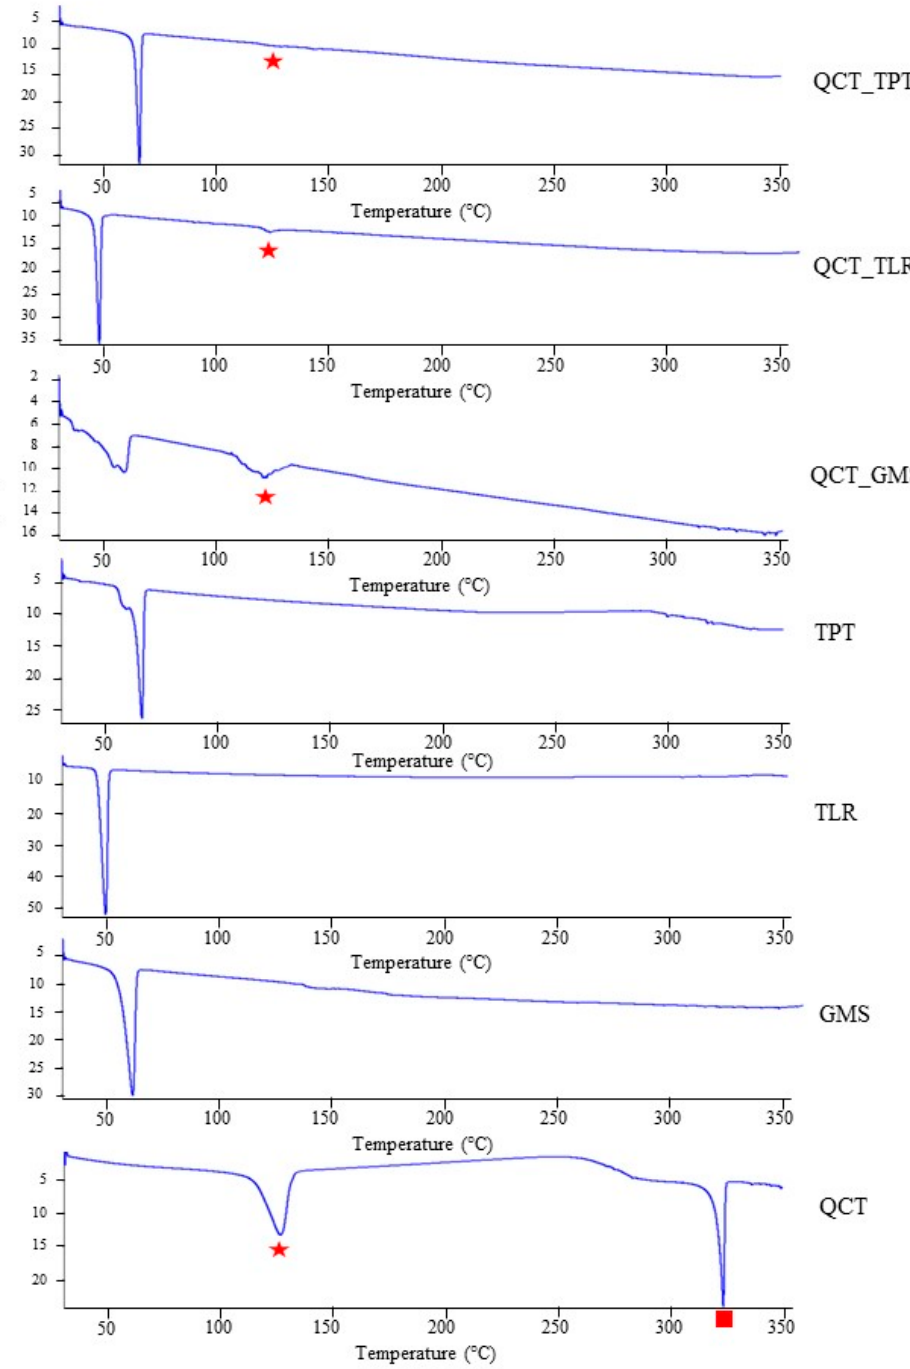
Figure 4. DSC thermograms of QCT, solid lipids (TLR, TPT, and GMS), and SLNs prepared using different types of solid lipids. Red square and red star represents the melting point and dehydration of QCT, respectively.